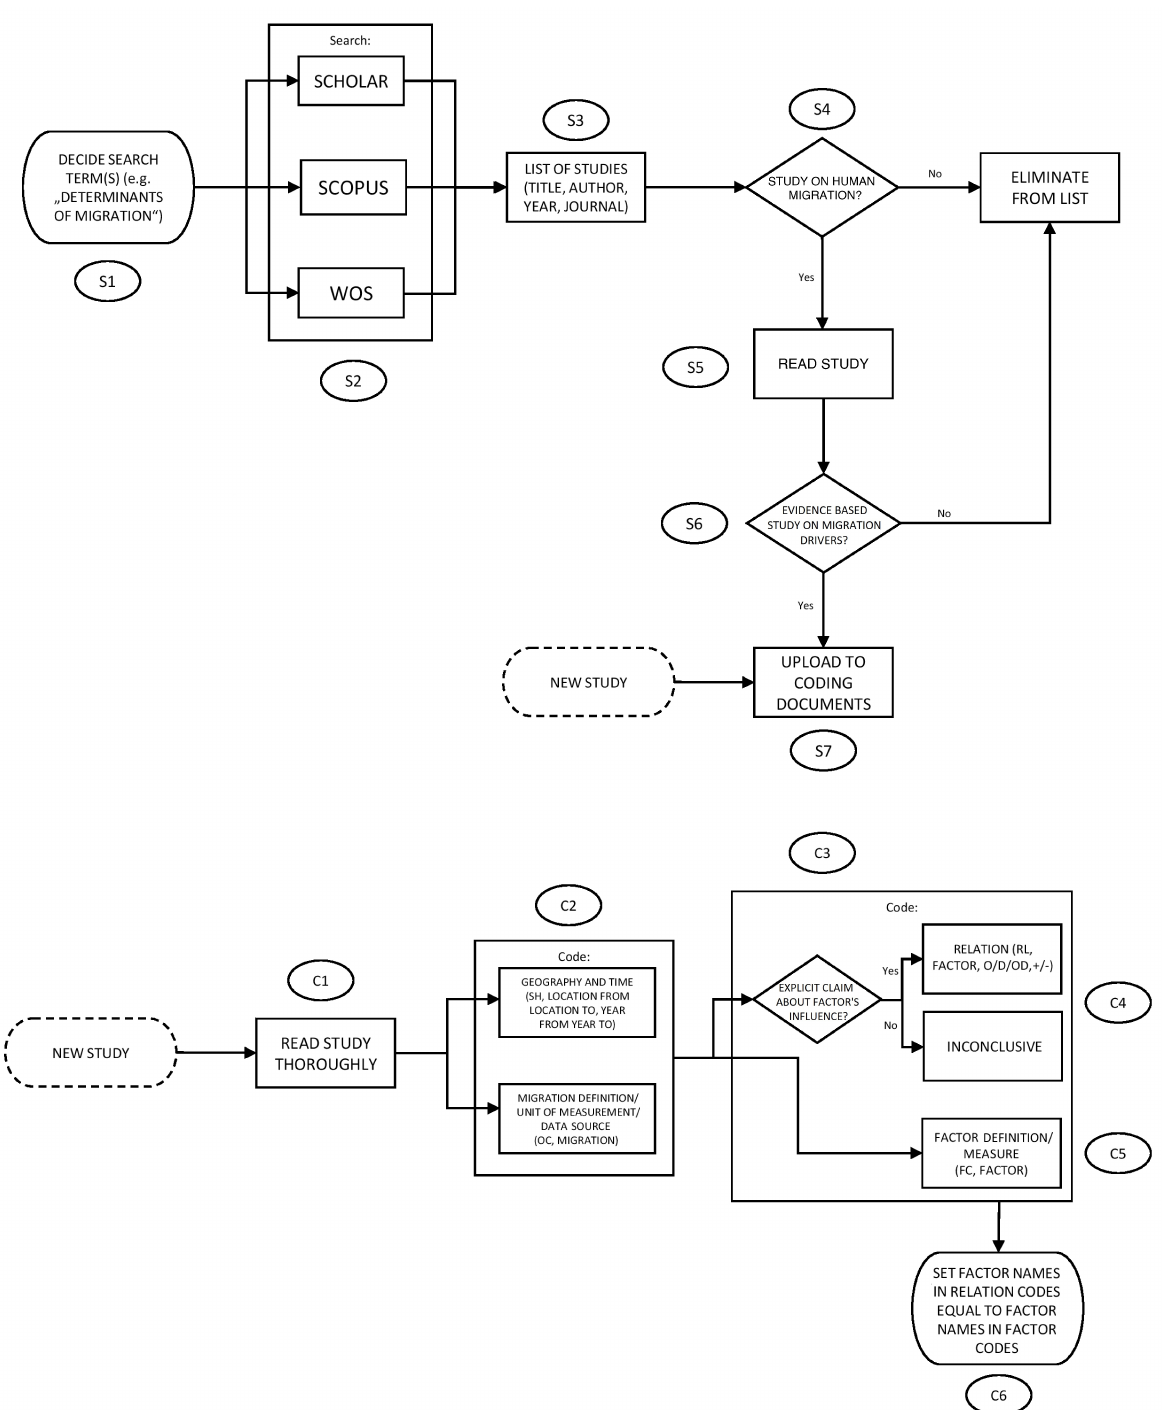
Figure 1. Literature selection (S) and coding (C)